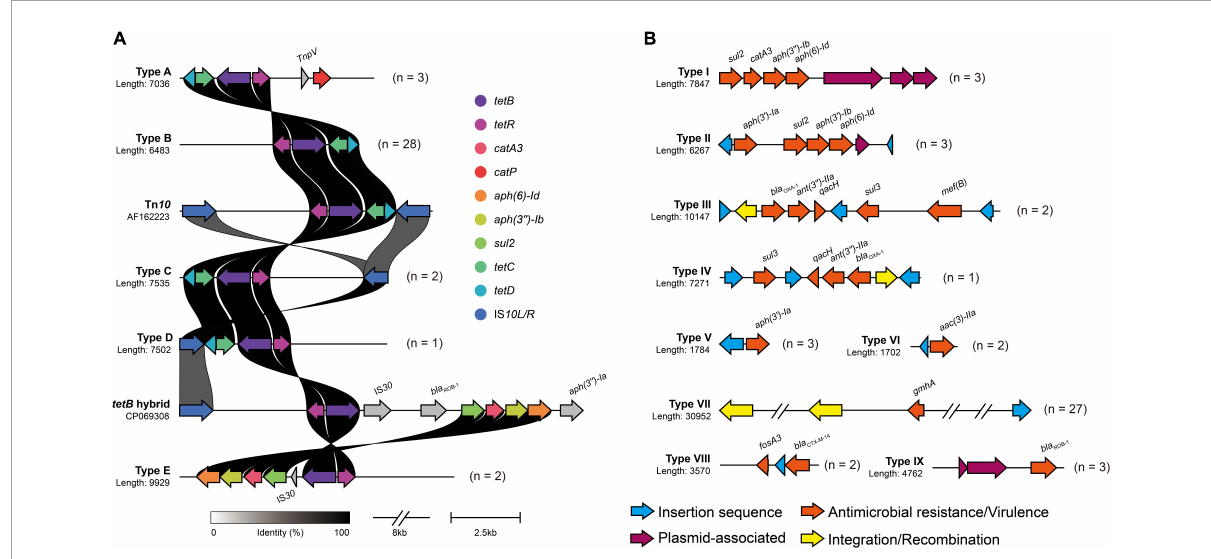
FIGURE5 Genetic environment of mobile virulence and antimicrobial resistance gene in A. paragallinarum . Different types of antimicrobial resistance gene clusters were shown in above figure, and numbers followed by genetic profile represented the total numbers of similar gene clusters in all A. paragallinarum . (A) Profiles of tetB cluster in A. paragallinarum . The major functional proteins in Tn 10 transposon, including TetB (tetracycline efflux protein), TetR (TetR family transcriptional regulator), TetC (transposon Tn 10 TetC protein), TetD (transposon Tn 10 TetD protein), and two insertion sequence IS 10L and IS 10R . Tn 10 transposon in Shigella flexneri (accession: AF162223) and tetB hybrid sequence in Glaesserella parasuis (accession: CP069308) served as reference sequences for the comparison of tetracycline resistance gene cluster in A. paragallinarum. The gray shading genes indicated that these determinants were dissimilarity among other sequences. (B) Diversity of mobile gene cluster in A. paragallinarum . Mobile gene clusters excluding tetB clusters were categorized into nine sequence